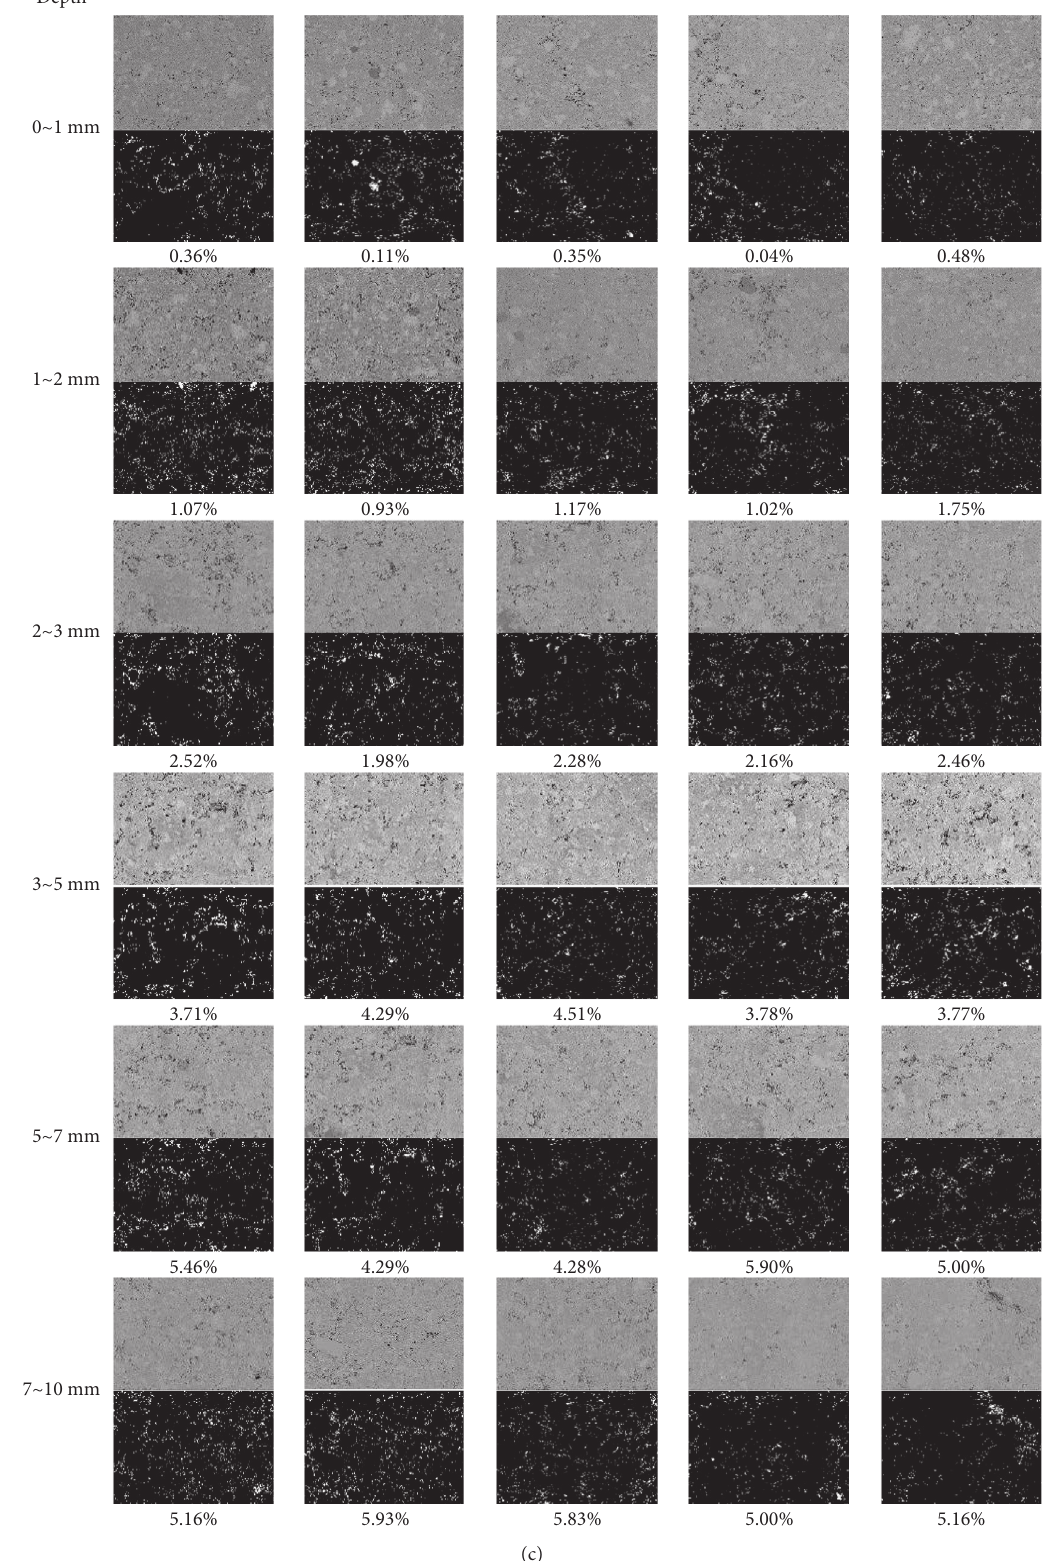
Figure 6: Representative original and binarised BSE images at incrementally different depths from treated surface for (a) control, (b) Silane Liquid, and (c) Silane Cr`eme together with porosity ratio